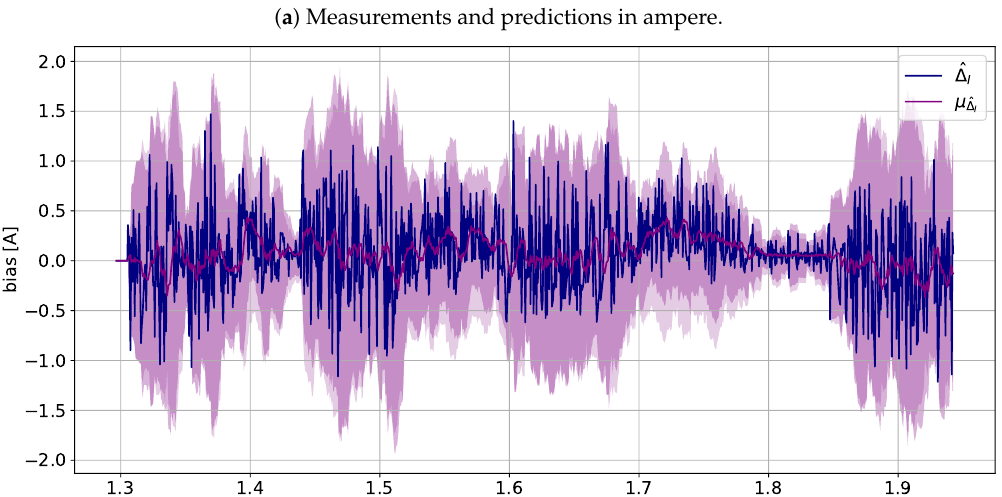
( a ) Measurements and predictions in ampere.